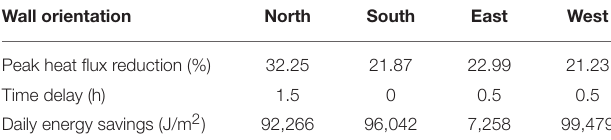
Frontiers in Energy Research |